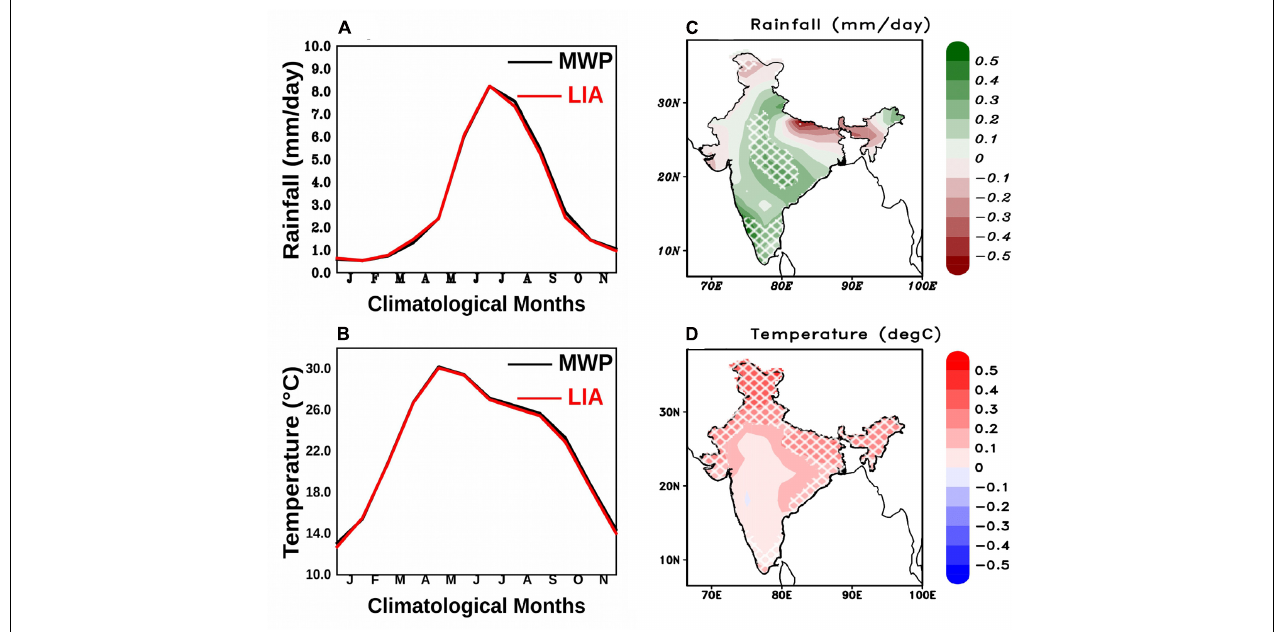
FIGURE 3 | Comparison between the area-averaged seasonal cycle of Medieval Warm Period (MWP) and Little Ice Age (LIA) period, (A) is for the simulated rainfall, and (B) is for the simulated surface temperature over Indian land region. Spatial distributions of the simulated summer monsoon rainfall (mm/day; C ) and surface temperature ( ◦ C; D ) for MWP with the difference to LIA. Hatched region represents a statistically significant region at an 80% confidence level from the two-tailed Student’s t -test.